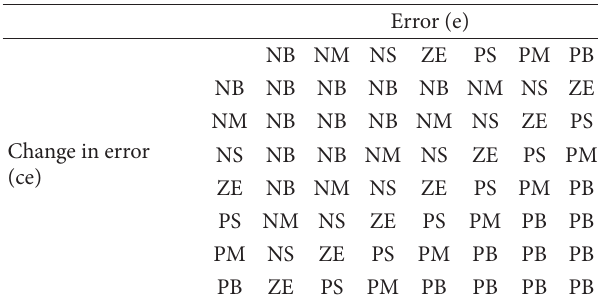
Table 1: Fuzzy rule.